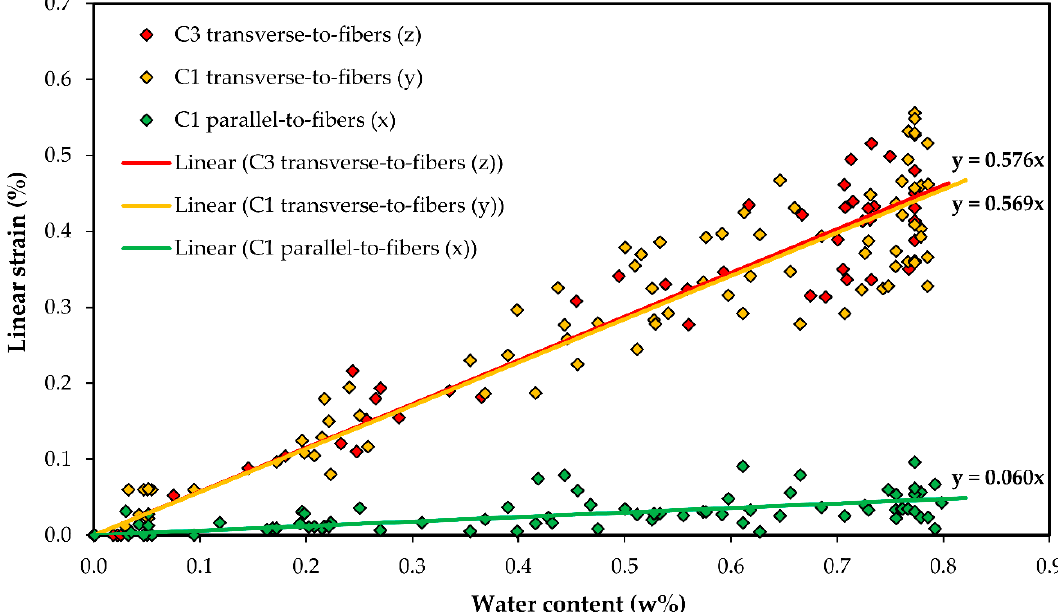
Figure 6. Experimental data and linear regression of orthotropic swelling for composites.